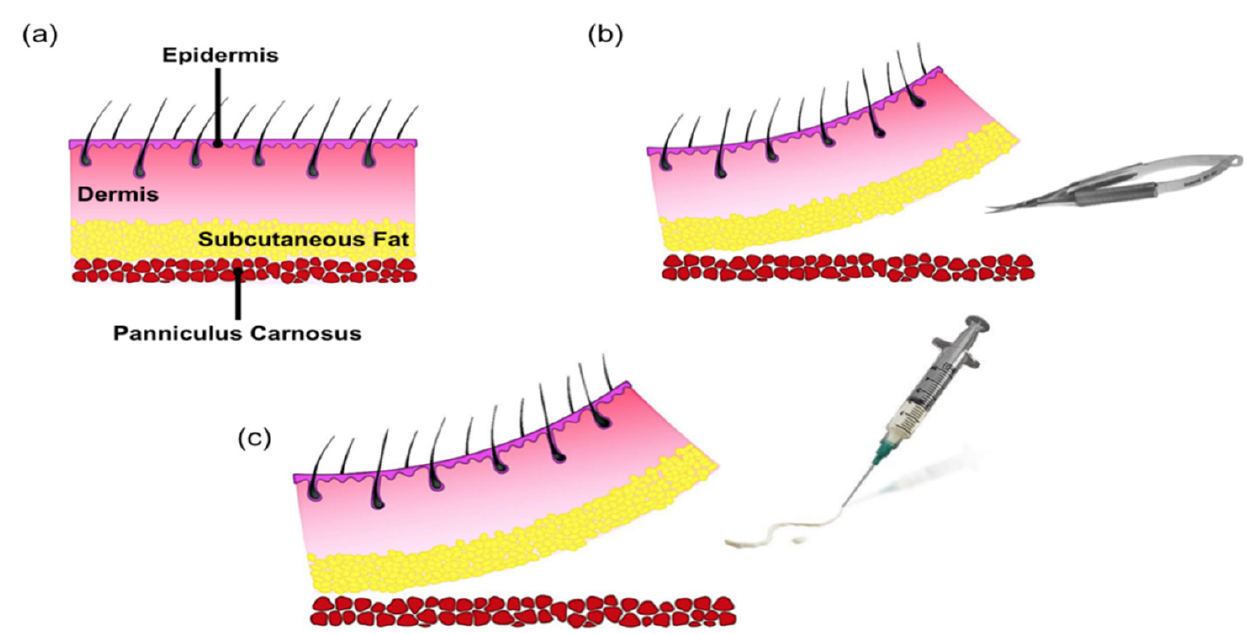
Figure 7. Diagram depicting the microsurgical technique used in the study. ( a ) Intact mouse skin. ( b ) Subcutaneous pockets were created by dissecting between the dermis and the panniculus car ‐ nosus muscle layer. ( c ) Each pocket received 200 μ L of Liquid Scaffold, GCBP, or sterile saline (sham control).